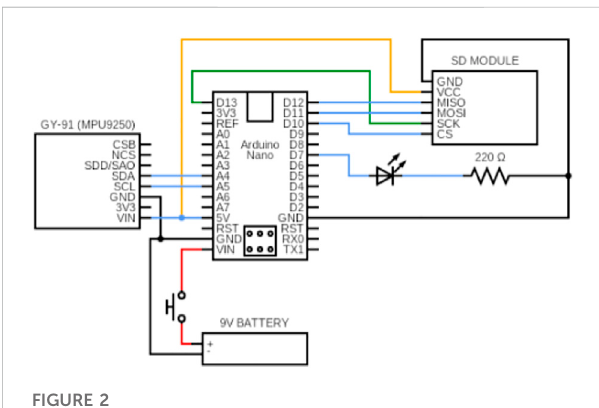
FIGURE 2 Electrical diagram of measuring